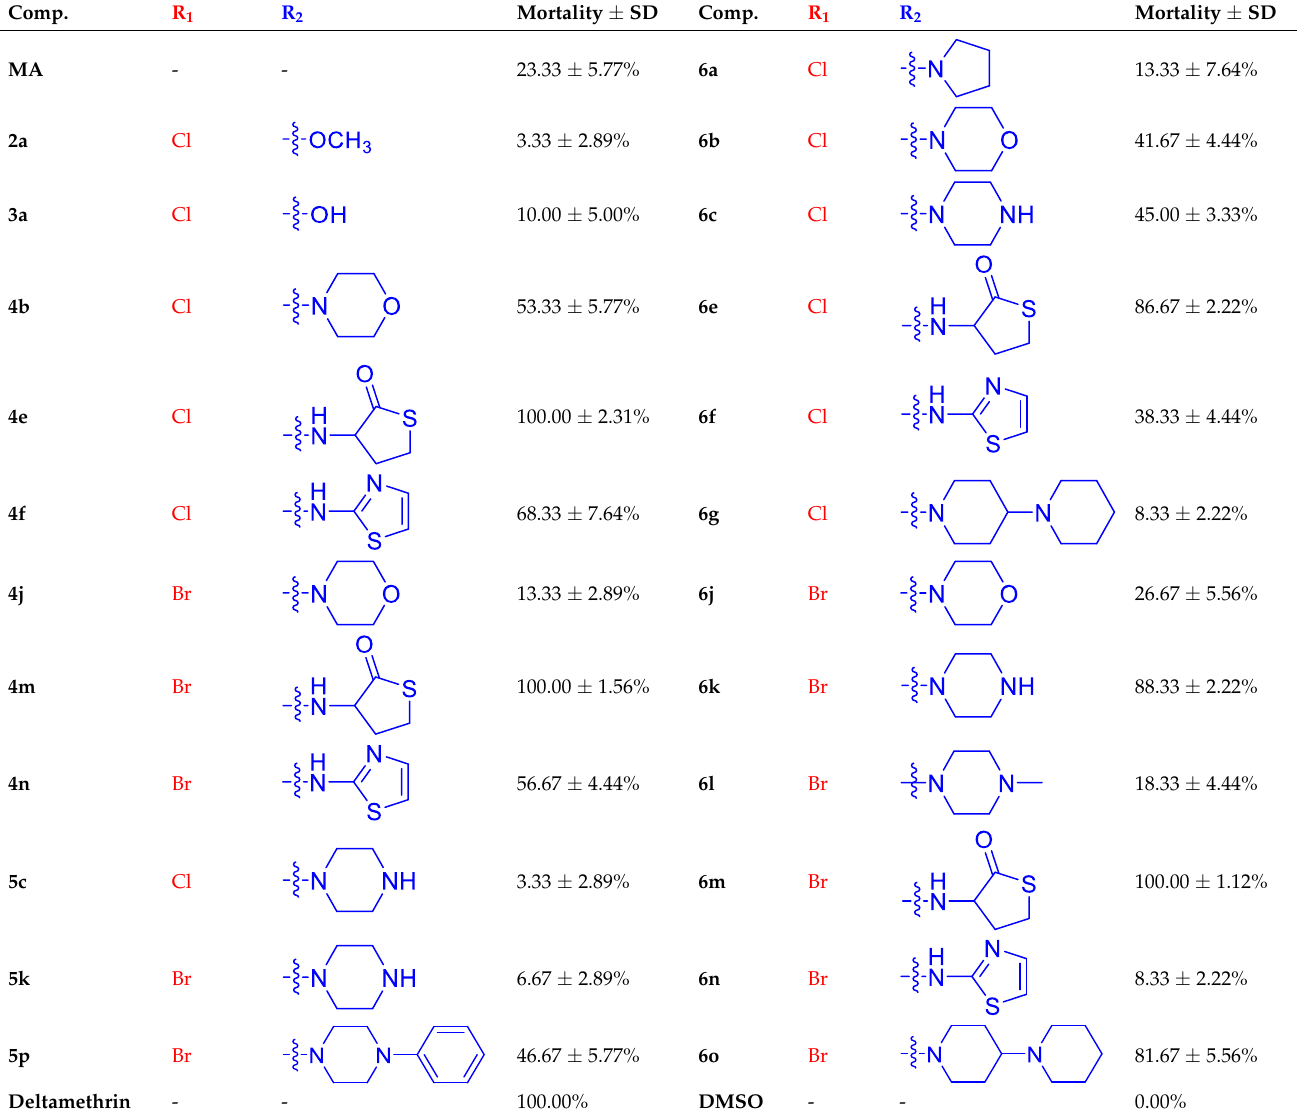
Table 1. Insecticidal activity against larvae of Ae. albopictus at 500 μg/mL. Comp.